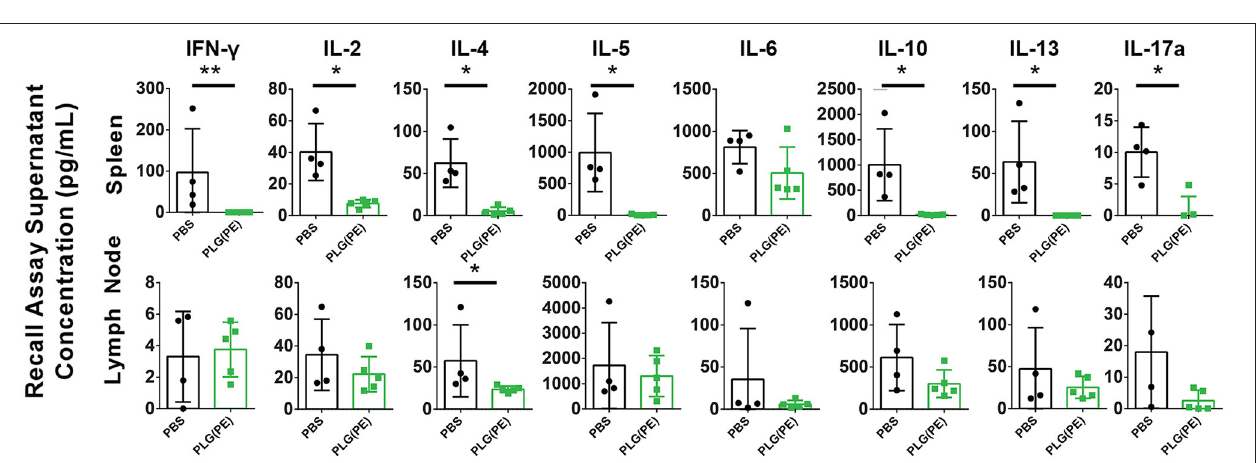
FIGURE 6 | Investigation of mechanisms involved with therapeutic efficacy of PLG(PE) in alum-sensitized mice. Mice were sensitized with alum on Days 0 and 14 and treated with PLG(PE) on Days 21, 28, and 38. Cytokine production from spleen or mesenteric lymph node cells cultured with crude peanut extract were measured by Luminex multiplex assay. Statistical significance determined by Mann-Whitney test: * P < 0.05, ** P < 0.01.